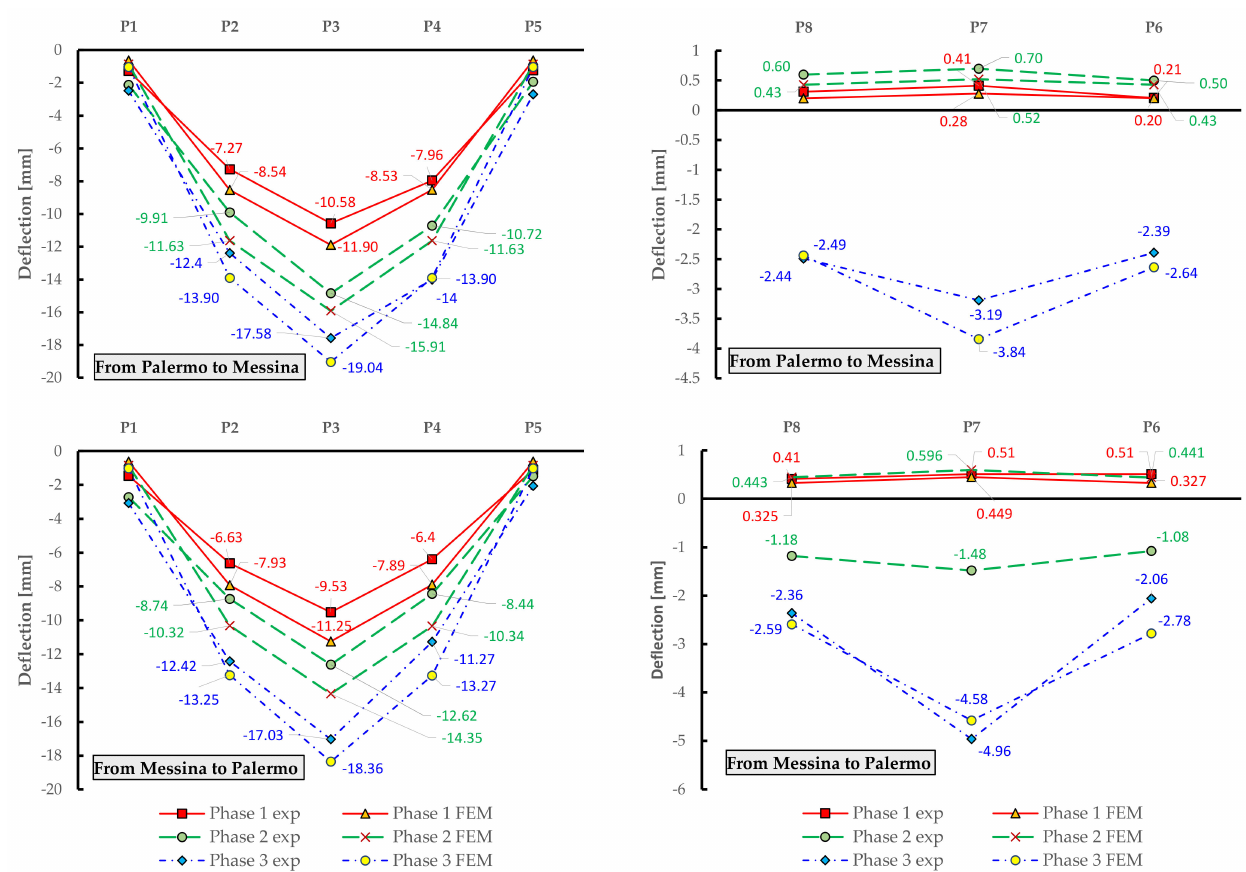
Figure 17. Comparison between experimental (exp) and numerical (FEM) displacements of the Longano bridge